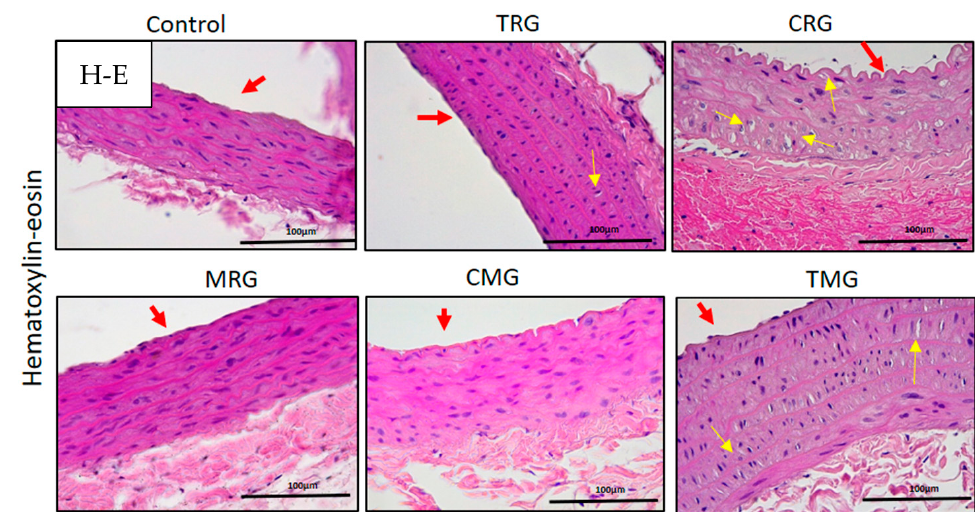
Figure 3. Aorta of rats treated with panels of immunosuppressive drugs. TRG, CRG, TMG—yellow arrows indicate changed shape of vascular smooth muscle cells in media; CRG—folded tunica intima. Red arrows indicate aortal intima. Hematoxylin-eosin (H-E) staining. Objective magn. ×40; bar 100 μ m.